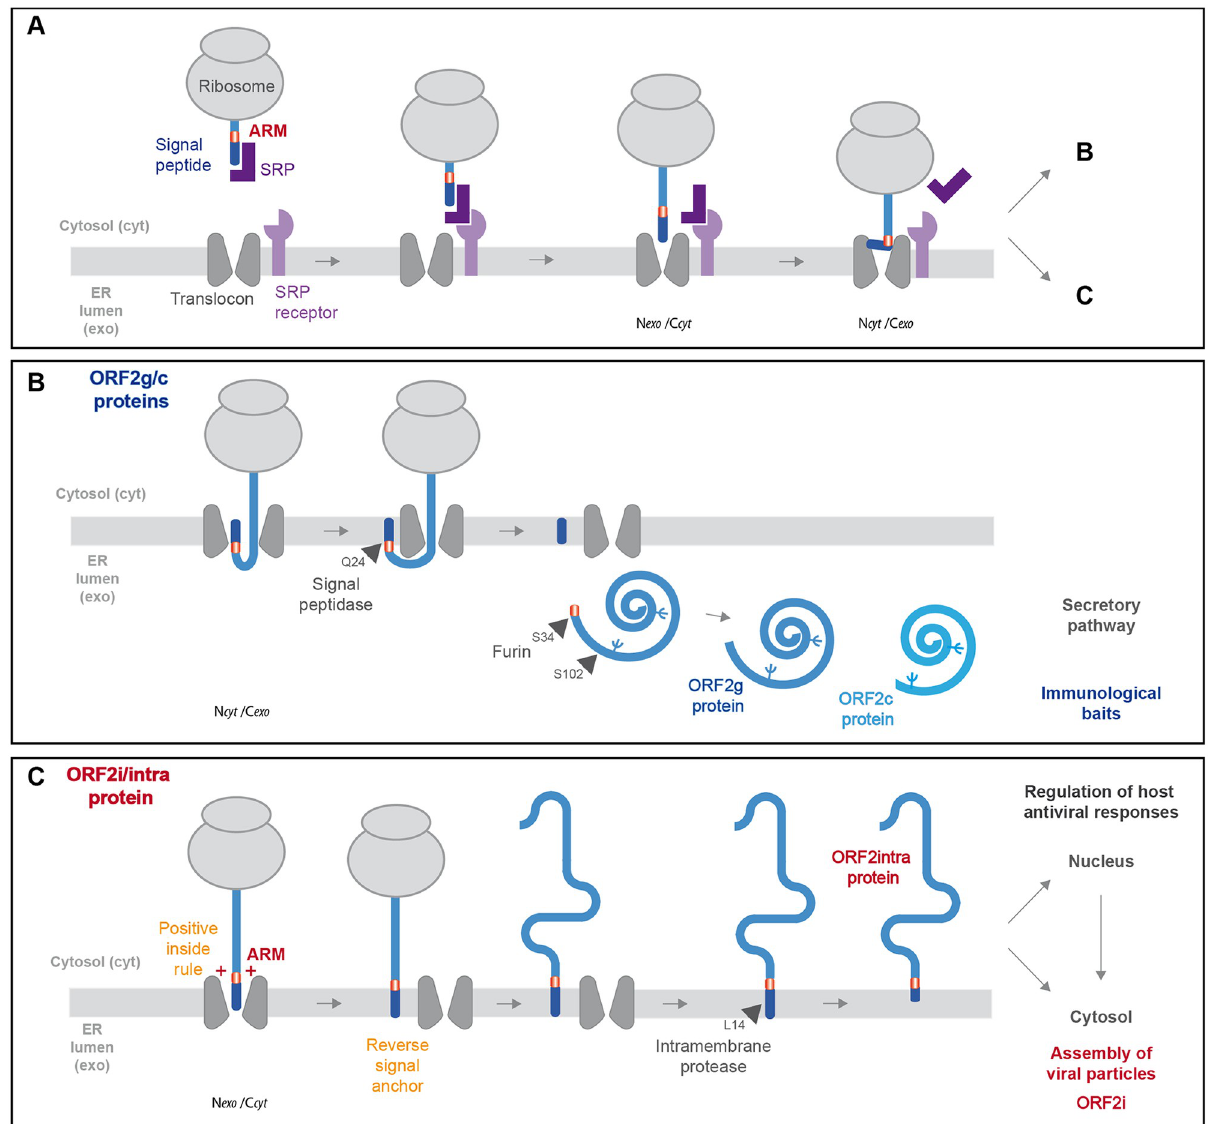
Fig 9. Model of ORF2 addressing regulation by ARM. (A) The signal recognition particle (SRP) recognizes the hydrophobic signal peptide (SP) of the ORF2 nascent chain as it emerges from a translating ribosome. The ribosome-nascent chain-SRP complex is targeted to the membrane and interacts with the SRP receptor, resulting in the release of the SP and docking of the ribosome–nascent chain complex to the Sec61 translocon. The ORF2 SP initially inserts head-on in an N exo /C cyt orientation, then inverts its orientation to N cyt /C exo . (B) The C-terminal end of SP is exposed to ER lumen and is cleaved by signal peptidase, generating a new N-terminus. Translation then resumes, and the nascent ORF2 protein is translocated into the ER lumen where it is glycosylated and likely undergoes maturation by the proprotein convertase furin. This pathway generates the ORF2g/c forms. (C) For a /C orientation and integrates as reverse signal-anchor, fraction of ORF2 nascent polypeptide chains, the ARM leads the ORF2 SP to retain its N exo cyt according to the positive-inside rule. The ORF2 protein anchored to the cytosolic side of membrane is likely processed by an intramembrane protease to generate the ORF2i/ORF2 intra protein that is translocated into the nucleus and assembles into viral particles.